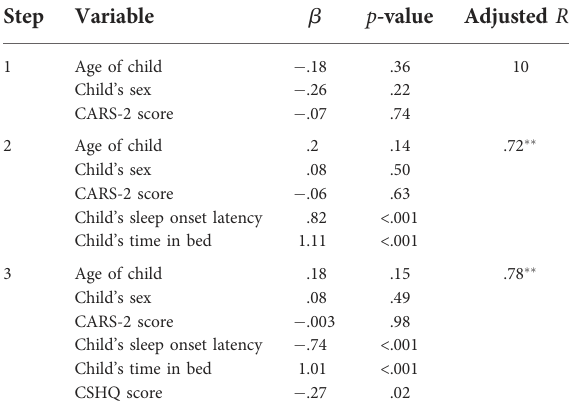
TABLE 7 Hierarchical multiple regression predicting Actual Sleep Time in